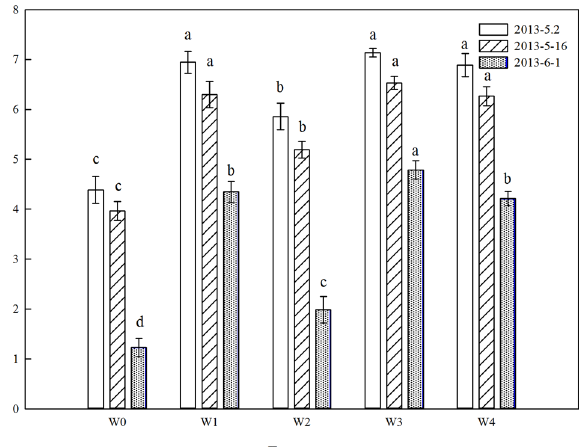
Figure 3. Changes of leaf area index (LAI) at May 2, May 16, and June 1 in 2013 of different treatments in 2012/2013 growing season: rainfed (W0), a local supplemental irrigation practice with 60 mm of irrigation each at jointing and anthesis (W1), supplemental irrigation determined by measuring 0–20 cm (W2), 0–40 cm (W3), and 0–60 cm (W4) soil layers moisture and brought the soil moisture to 65% field capacity (FC) at jointing and 70% FC at anthesis. At the same measuring day, the different letters in the figure are significant at the 0.05 level. Vertical bars are standard error of the mean (n =